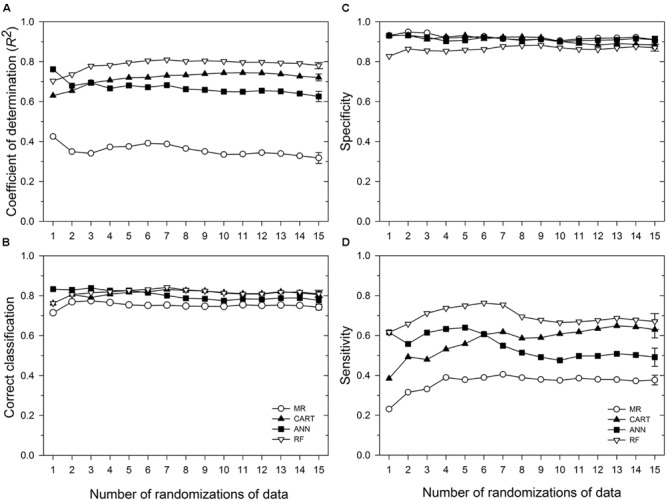
Performance in predicting Stagonospora nodorum blotch (SNB) of wheat of a multiple regression (MR) model and three machine learning models: ANN, categorical and regression tree (CART), and random forest (RF). Based on running averages of 15 randomizations of the test dataset which comprised 10% of 431 cases collected in the study. (A) coefficient of determination; (B) correct classification rate, i.e., proportion of cases correctly classified as low-severity (<30% disease severity) or high-severity (≥30% disease severity); (C) specificity, the proportion of cases correctly classified as low-disease; and (D) sensitivity, the proportion of cases correctly classified as high-disease. Symbols represent mean values for any given number of randomizations of the test dataset, while the vertical bars represent standard errors of the mean based on the total number of randomizations evaluated. Means whose standard error bars do not overlap are statistically different at α = 0.05.